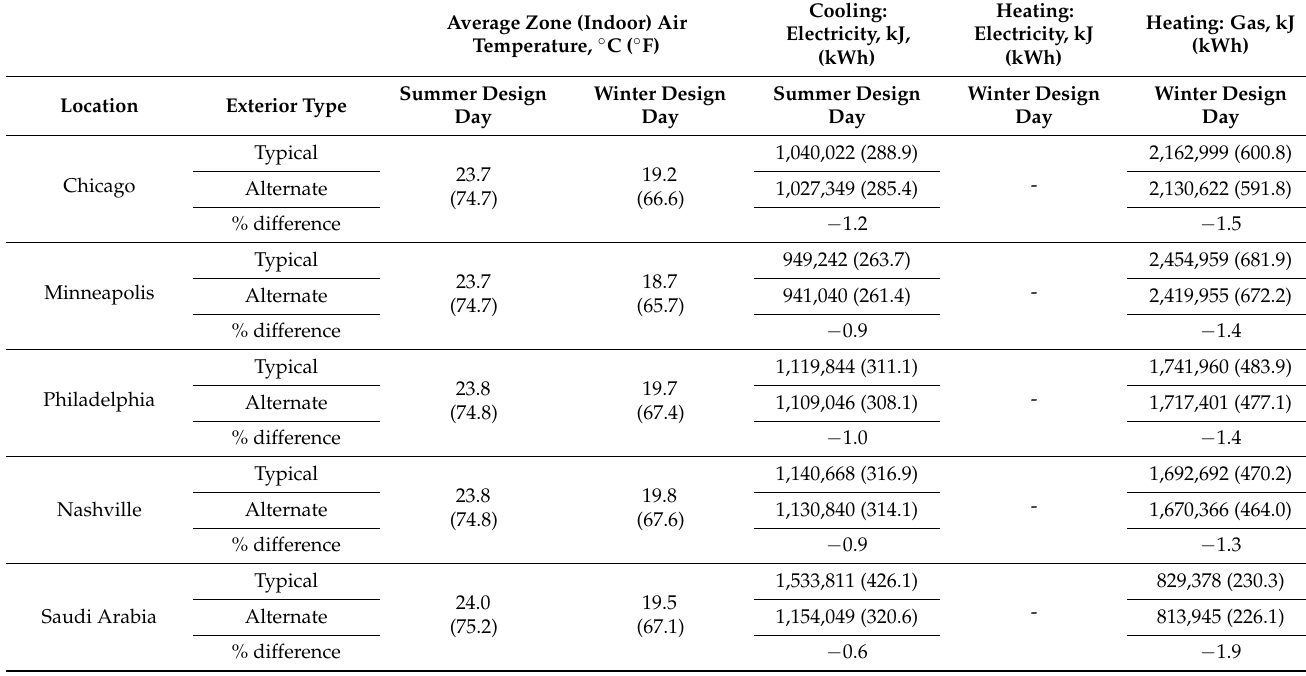
Table 9. Results for secondary school reference model building energy simulations.